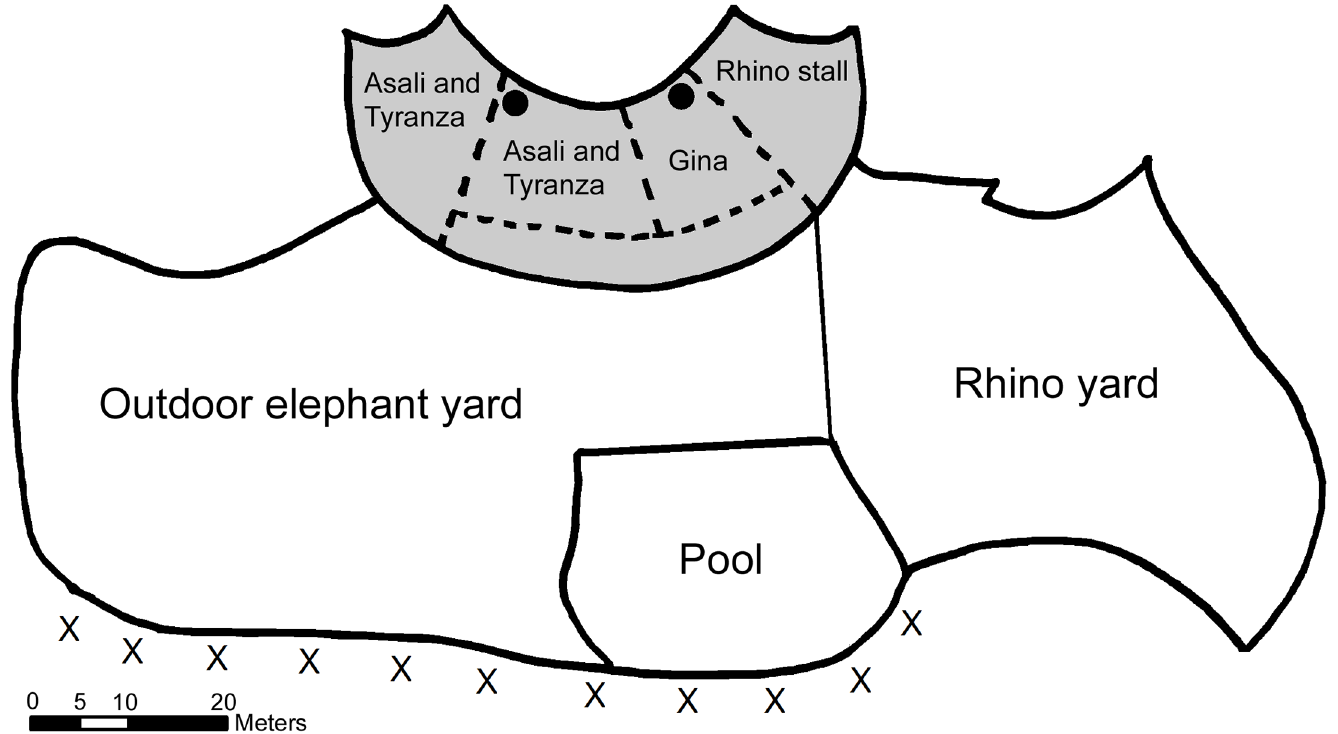
Fig 1. Map of the indoor and outdoor exhibits. The indoor area where flooring was replaced is noted in grey. Circles represent position of indoor video cameras for recording nocturnal behavior. Observations of diurnal outdoor behavior were taken in locations noted by X along the perimeter of the